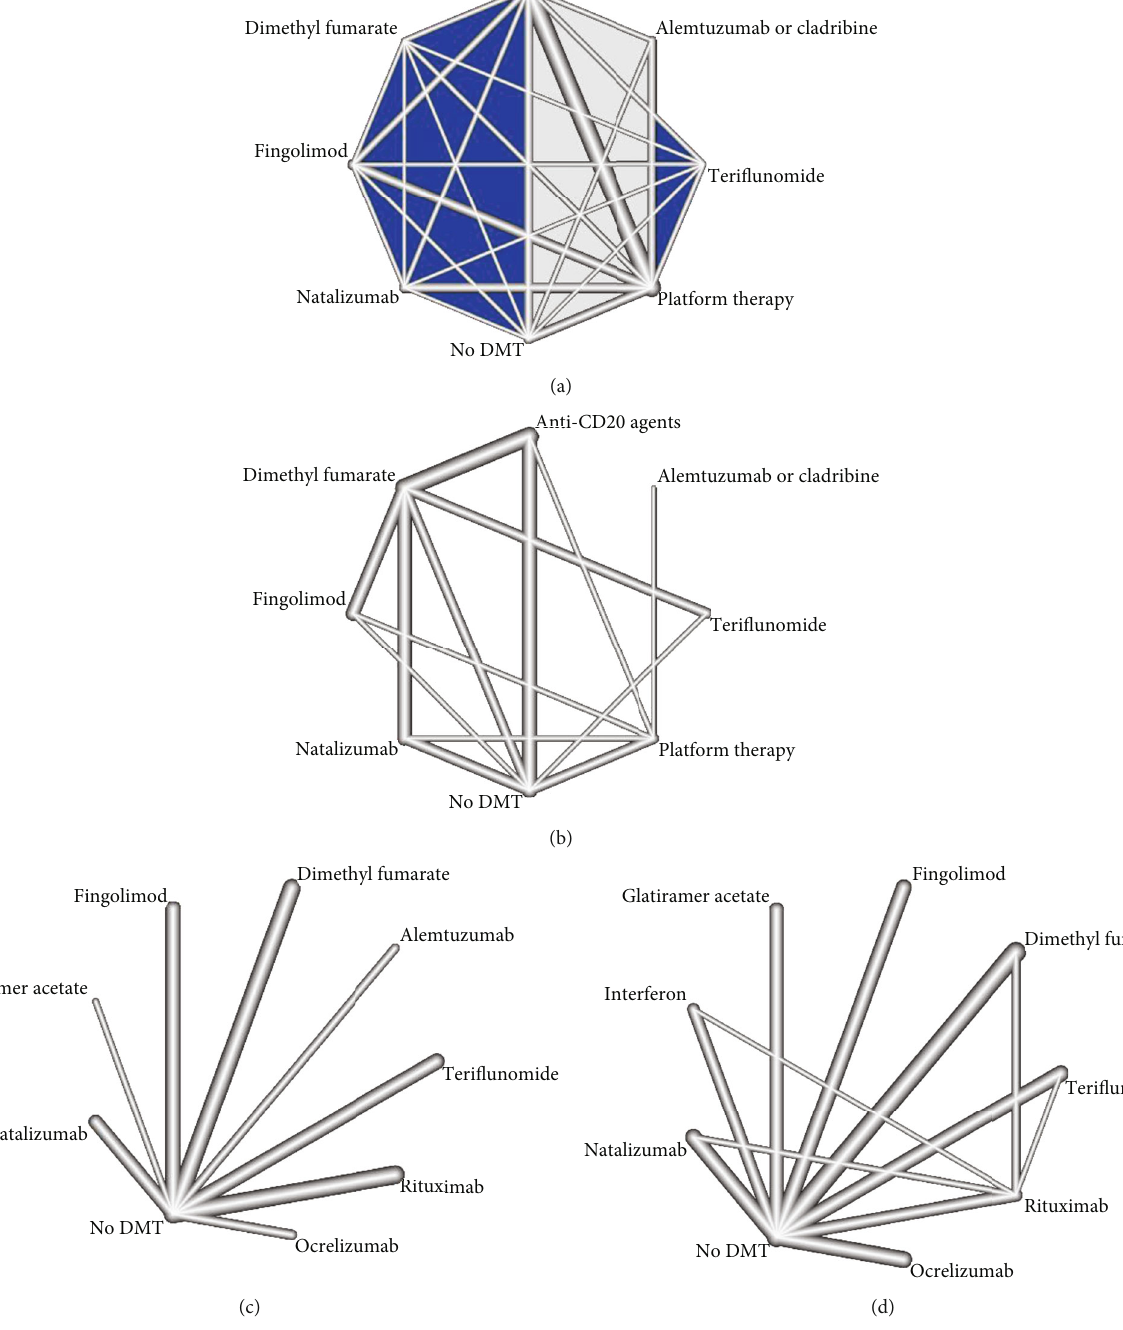
Figure 2: Network plots the e ff ect of DMTs on the risk of acquiring COVID-19 and its severity. Platform therapy: interferon and glatiramer acetate; anti-CD20 agents: rituximab and ocrelizumab. (a) Risk of acquiring infection based on a univariate model. (b) Risk of acquiring infection based on a multivariate model. (c) Risk of severe infection based on a univariate model. (d) Risk of severe infection based on a multivariate